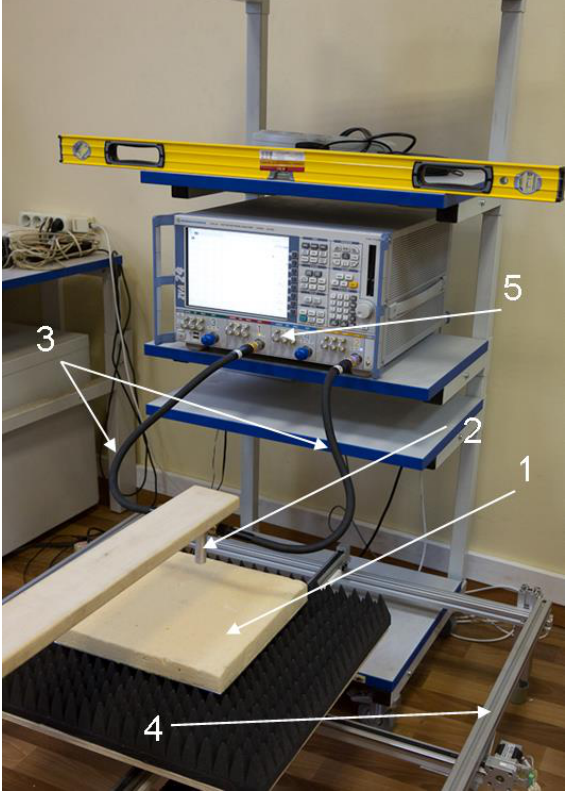
Figure 23. Experimental high-precision HSR system: (1) test sample, (2) antenna, (3) cables, (4) electromechanical scanning bed, and (5) VNA (ZVA 24).